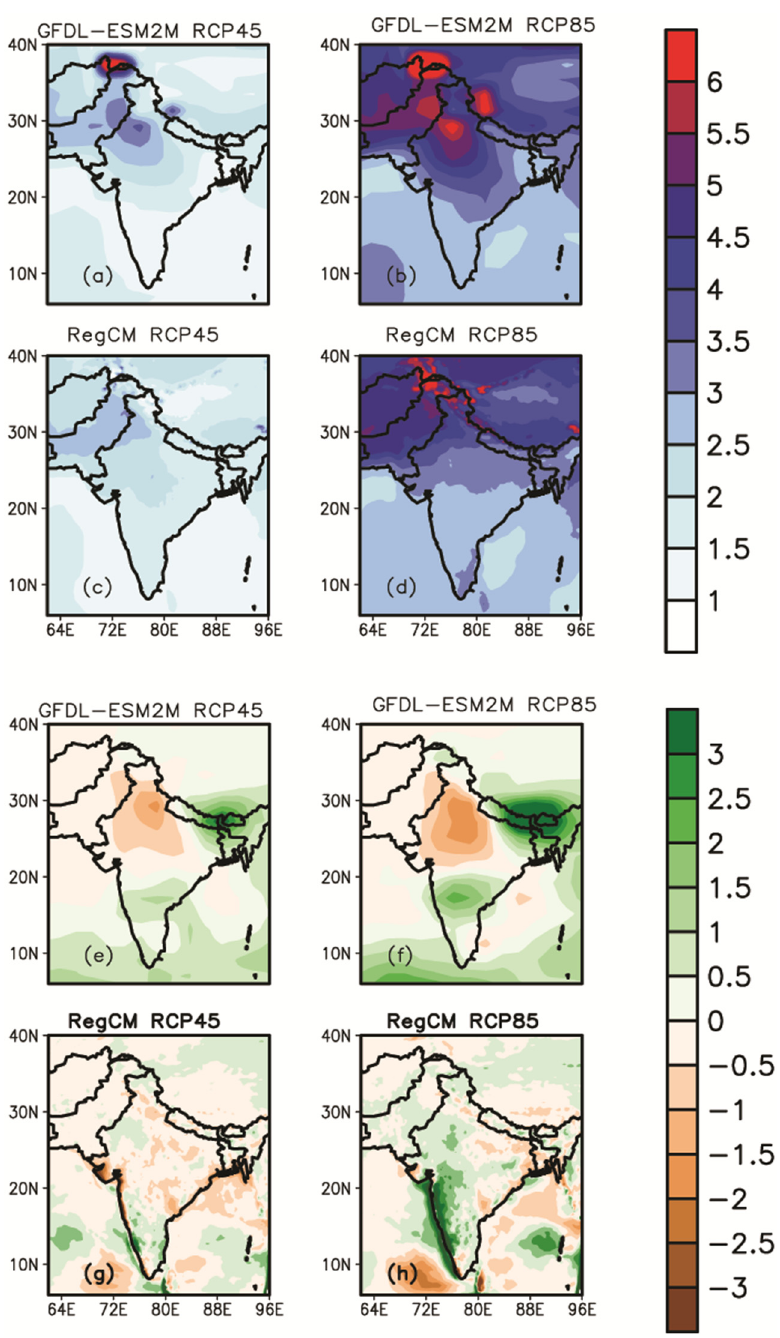
Figure 8. Projected changes (2070–2099 minus 1976–2005) in SASM mean temperature for ( a , b ) GFDL − ESM2M (RCP45 and 85); ( c , d ) RegCM4 (RCP4.5 and 8.5) and precipitation for ( e , f ) GFDL − ESM2M (RCP4.5 and RCP8.5); and ( g , h ) RegCM (RCP4.5 and